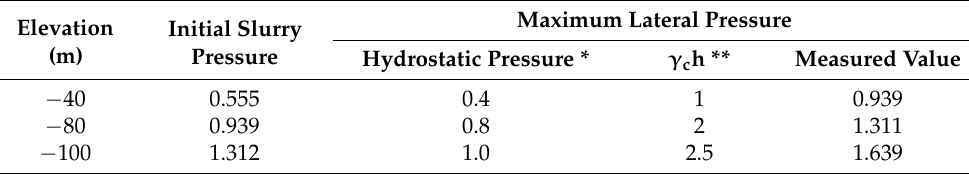
Table 5. Summary of the lateral pressure during the filling process